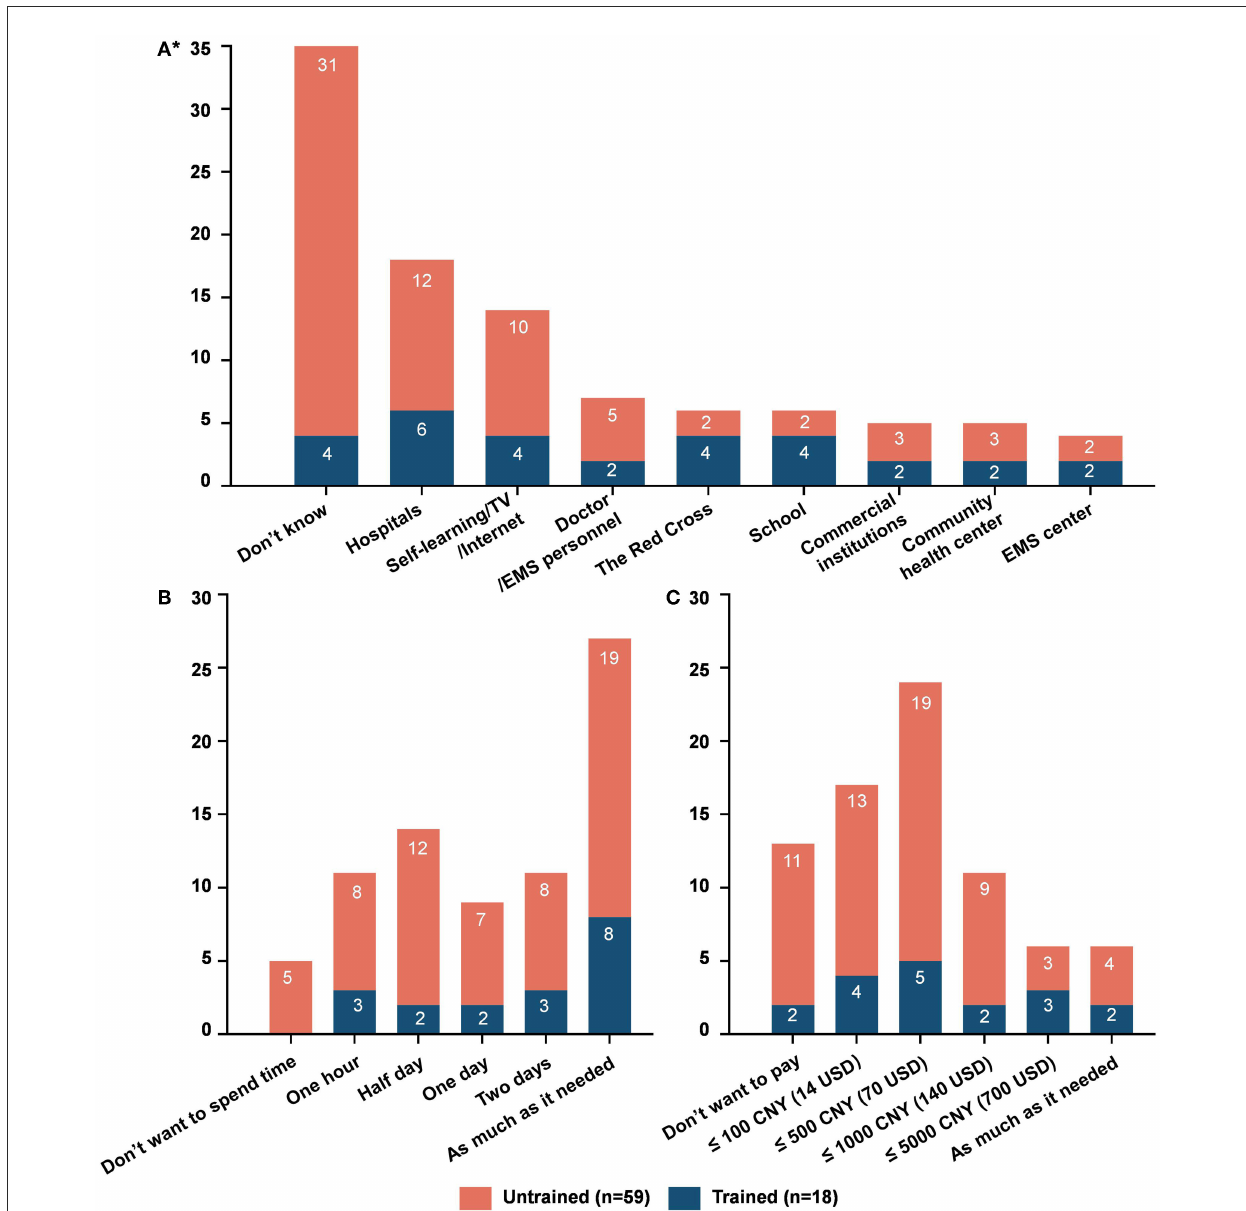
FIGURE3 Demand-side respondents’ perceptions of where to get CPR training (A), and willingness to spend time (B) and money (C) on CPR training courses. *means that multiple responses were allowed for question A. Values are shown as exact numbers. EMS, emergency medical services; CNY, China Yuan (1 CNY ≈ 0.14